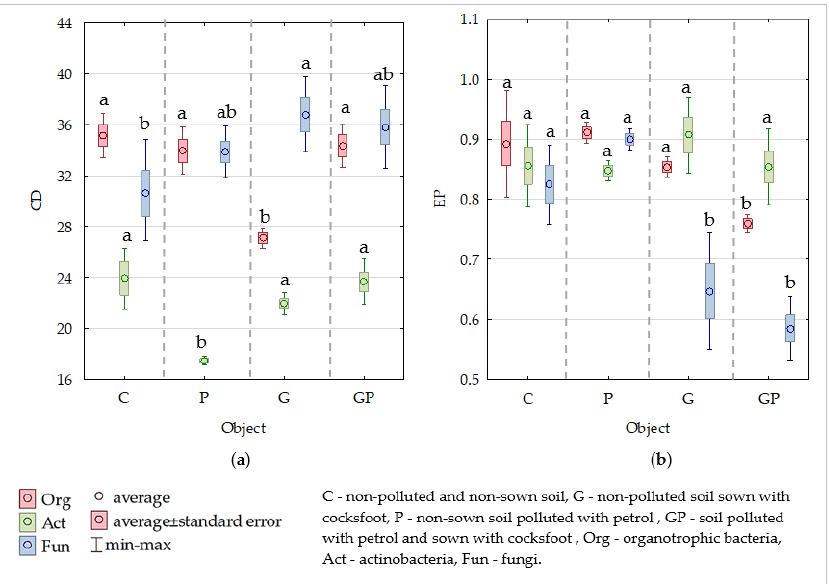
Figure 2. Effect of petrol (P) and cocksfoot (G) on changes in ( a ) the colony development (CD) in- dex, and ( b ) soil microorganisms and the value of their ecophysiological diversity (EP) index. Ho- mogeneous groups denoted with letters (a,b) were calculated separately for each of the microor-